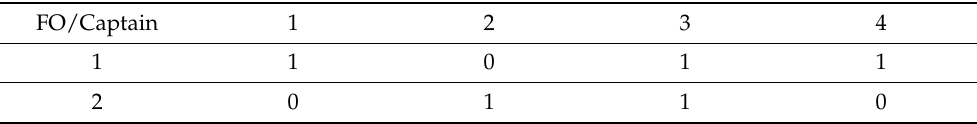
Table 2. Incidence matrix E representing the permissibility of creating crews with the captain and first officer.